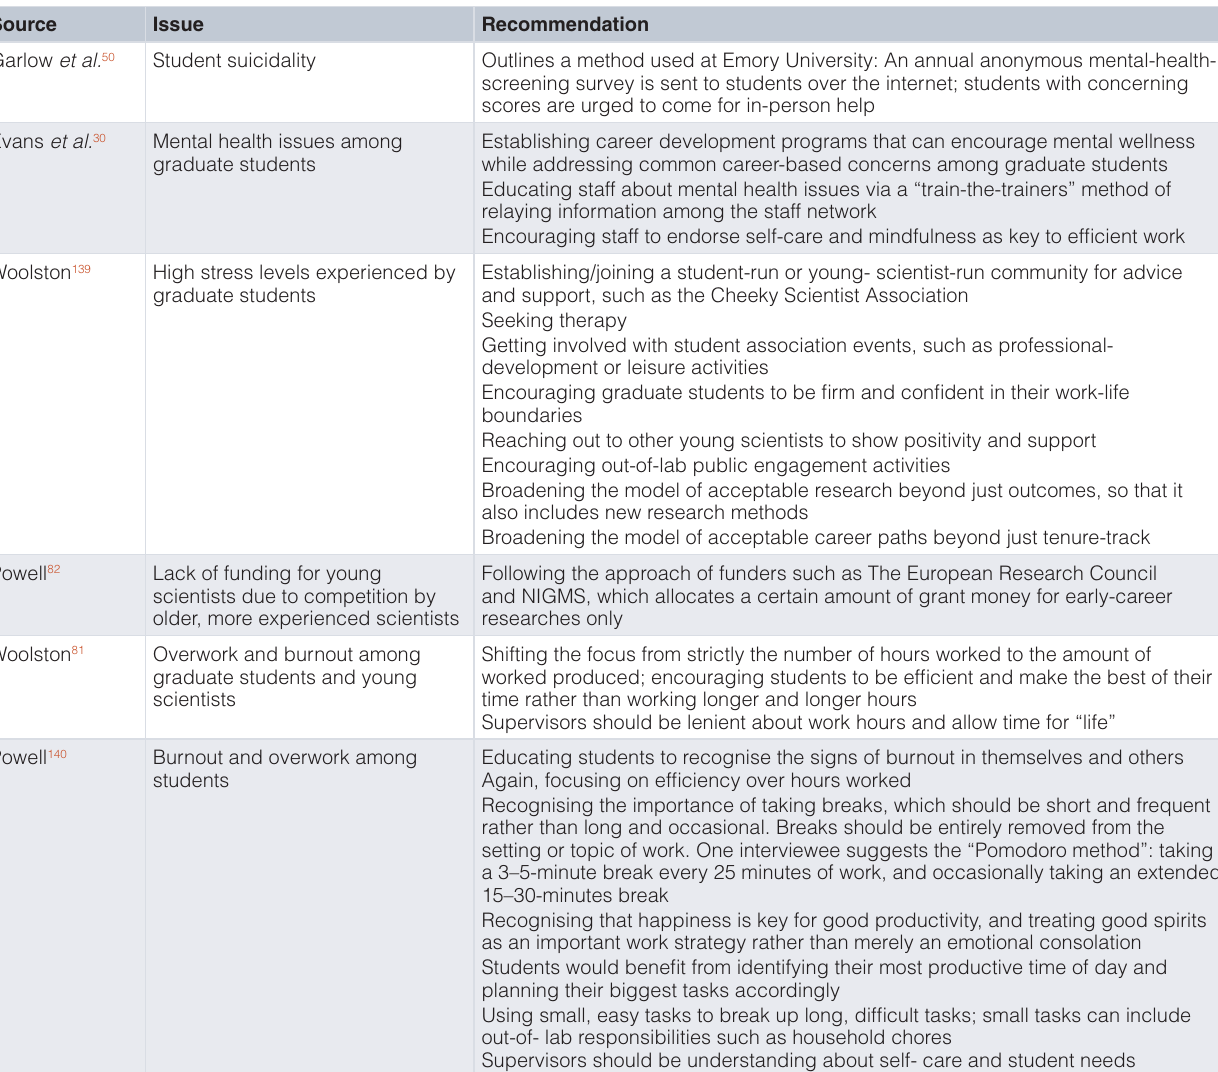
Table 9. A summary of institutional and cultural changes recommended by the authors featured in this